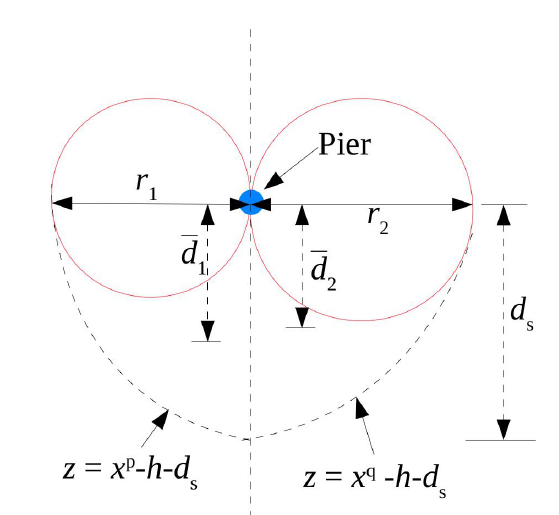
Figure 2. op view of the scour hole around a circular pier. r 1 and r 2 are the radii of the top surface of the scour holes at the front and the rear side of the pier; ¯ d 1 and ¯ d 2 are the distance of the centroids of the area bounded within the pier and the respective scour profiles at the upstream and the downstream portion of the pier, measured from the initial bed level,